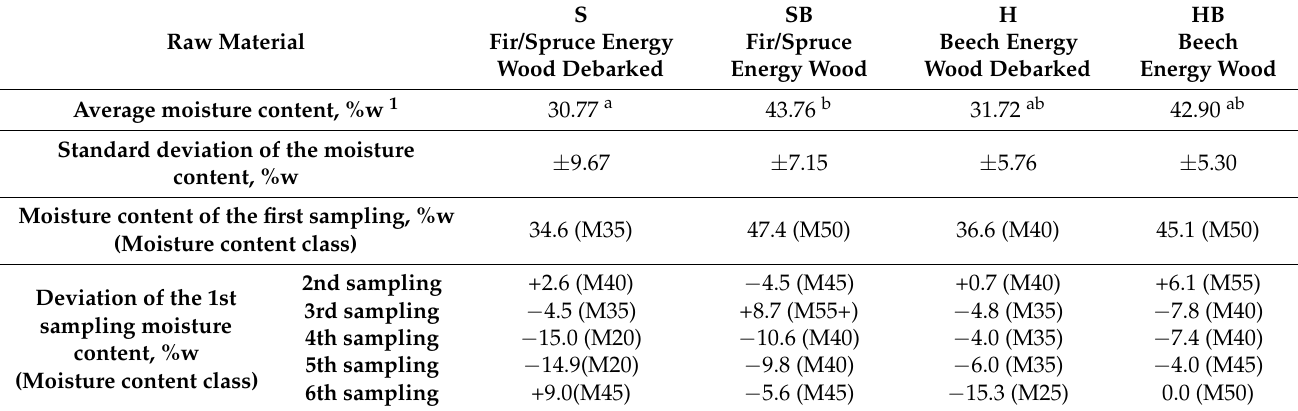
Table 1. Results of the moisture content